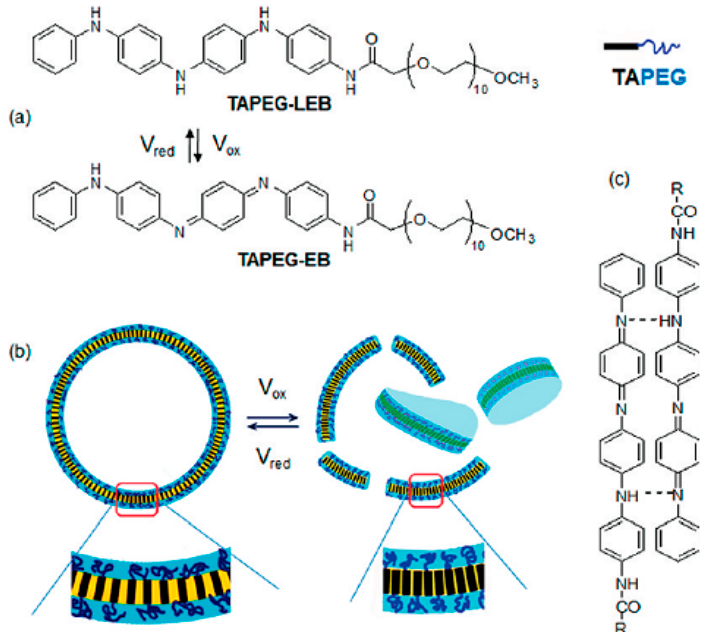
Figure 4. Electro-responsive tetraaaniline-PEG rod-coils in aquatic media, ( a ) chemical structures of TetraAaniline-PEG in the various oxidation states. ( b ) Redox switching results in vesicles rupture. ( c ) Hydrogen bonding of TAPEG [83], copyright American Chemical Society, 2011.